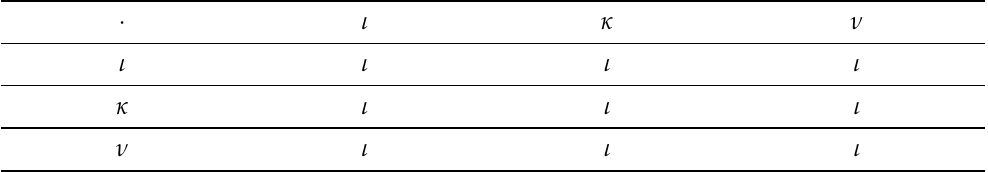
Table 5. Table of binary multiplication. ( S = { ι , κ , ν }